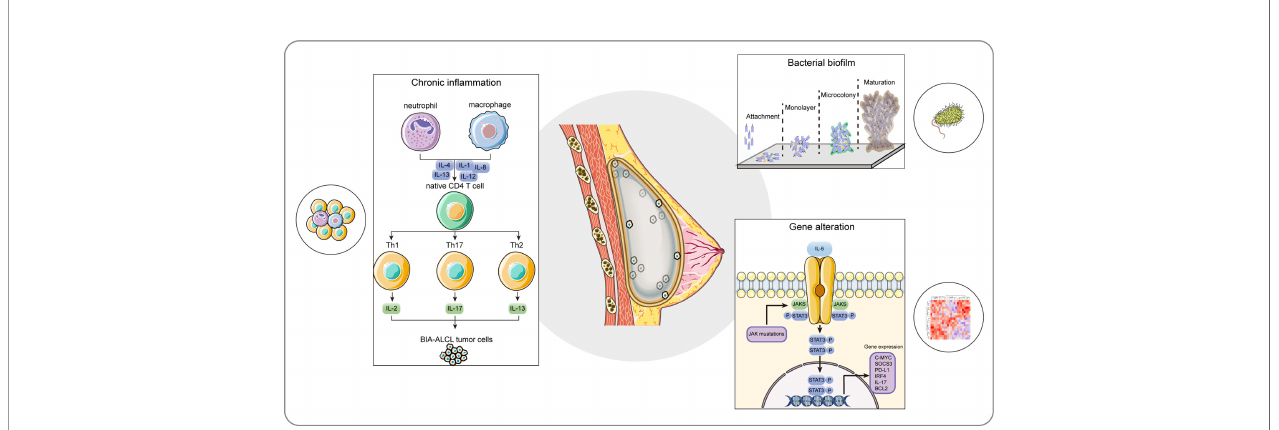
FIGURE 1 | The proposed hypothesis of the cellular and molecular etiological factors for BIA-ALCL. BIA-ALCL formation involves multiple interplays of internal and external factors collectively, including genetic predisposition, bacterial bio fi lm, chronic in fl ammation, and textured breast implant. The composition of the textured implant could be identi fi ed as a foreign antigen, and the textured surface of the implant provides a proper environment for bacterial bio fi lm colonization, formation, and development. Cytokines produced by bacterial infection and autoimmune activate CD4+ T cells, thus leading to a persistent chronic in fl ammatory state and resulting in the clone reproduction of activated CD4+ T cells. The aberrantly oncogenic JAK/STAT3 pathway mutations and IL-6-induced overexpressed STAT3 signal pathway promote phenotypic differentiation of Th1/Th17 and Th2 lymphocytes. These factors together ultimately result in the uncontrolled T cell clone expansion and the formation of BIA-ALCL. BIA-ALCL, breast implant-associated anaplastic large cell lymphoma; IL-1, interleukin-1; IL-2, interleukin-2; IL-4, interleukin-4; IL-8, interleukin-8; IL-12, interleukin-12; IL-13, interleukin-13; IL-17, interleukin-17; JAK, Janus kinase; STAT3, transcription factor